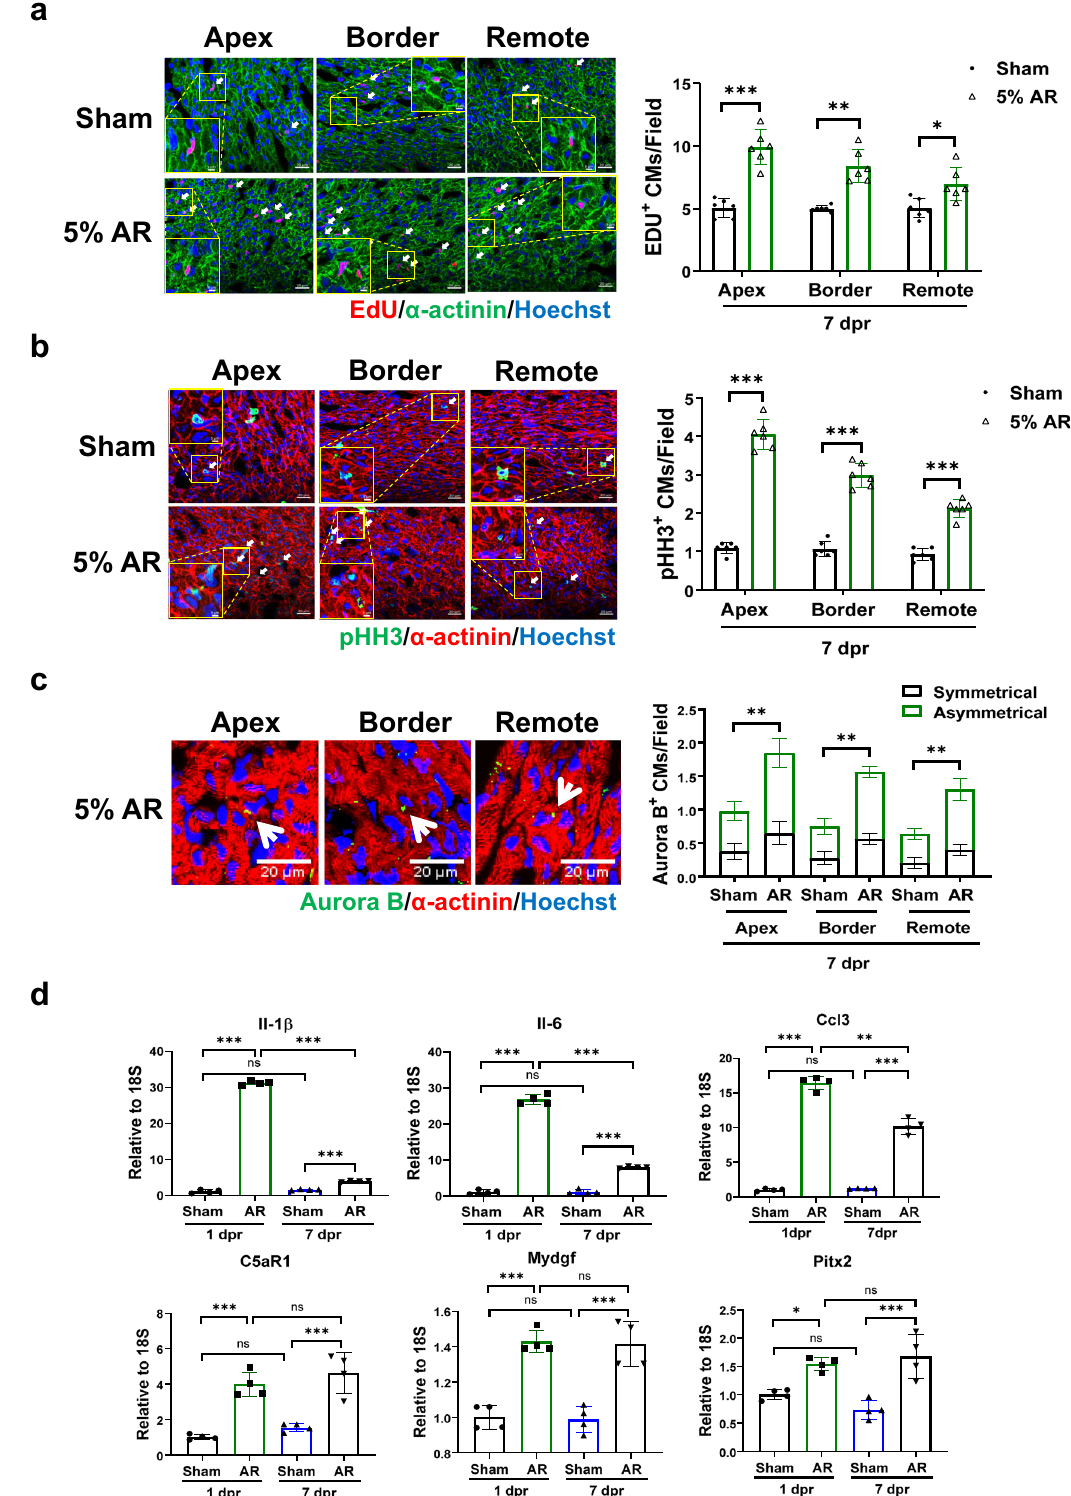
Fig. 6 Regenerative responses after 5% modi fi ed apical resection surgery in 1-day-old neonatal rats. Co-immuno fl uorescent staining for α -actinin and EdU ( a ) or phospho-histone H3 (pHH3) ( b ) in sham and apical resection (AR) hearts at 7 days post resection (7 dpr) ( n = 6). Scale bar = 20 μ m. A selected area with a higher magni fi cation (Scale bar = 5 μ m) for each representative image was presented. c Co-immuno fl uorescent staining for α -actinin and Aurora B at 7 dpr to evaluate Aurora B-kinase expression at the cleavage furrow between two cardiomyocytes ( n = 4). The representative asymmetrical Aurora B positive cardiomyocytes were indicated by white arrows. Scale bar = 20 μ m. d Quantitative PCR for in fl ammatory and immunomodulatory factors and myocardial pro-proliferative factors in sham and AR hearts at 1 dpr and 7 dpr ( n = 4). * P < 0.05; ** P < 0.01; *** P < 0.001; ns not signi fi cant. All data are expressed as means ±